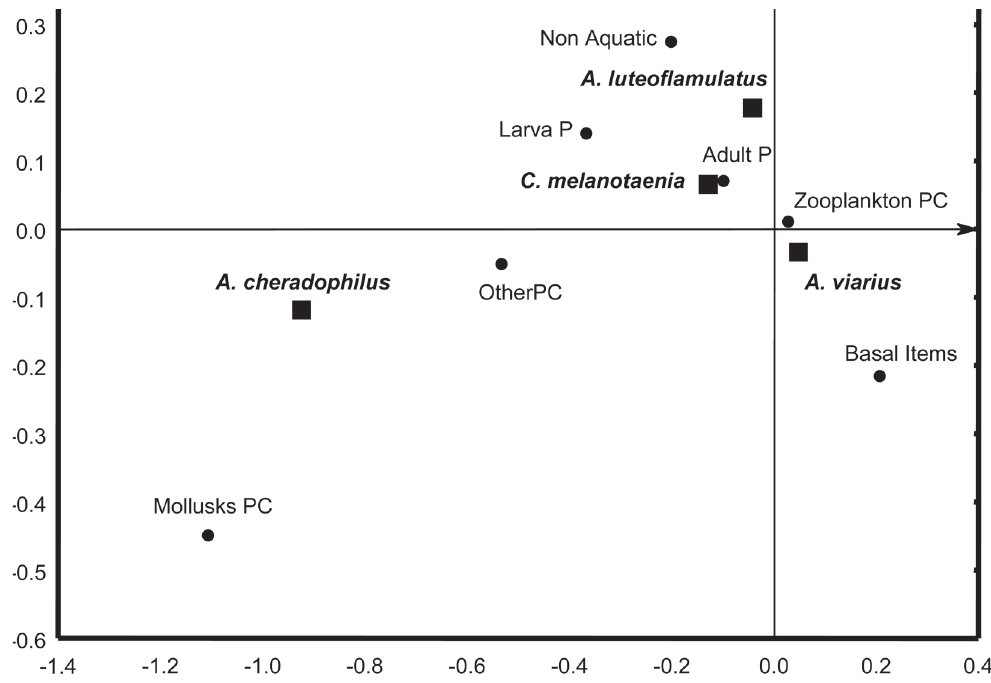
Fig. 7. Correspondence analysis of diet items (%) and the studied killifish species (%): Cynopoecilus melanotaenia , Austrolebias luteoflammulatus , A. viarius and A. cheradophilus . The preys were classified in Basal items, Primary Consumers (PC: Zooplankton, Molluscs and Other), Predators (P: Adult and Larva), and Non Aquatic